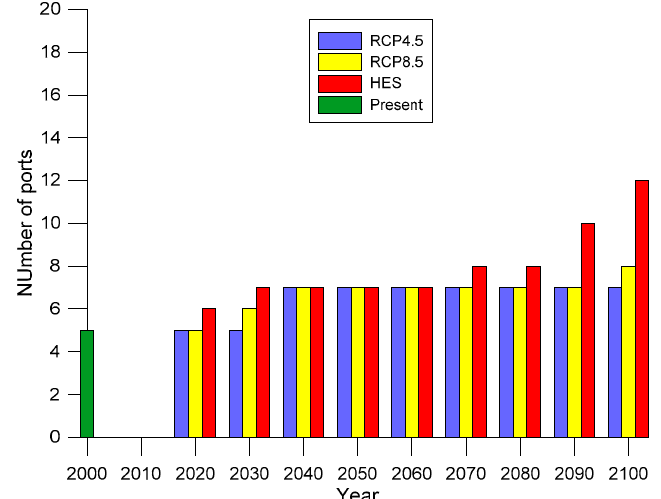
Figure 3. Number of ports with overtopping discharges greater than the tolerable ones, for the three SLR scenarios and for a return period of 5 years.